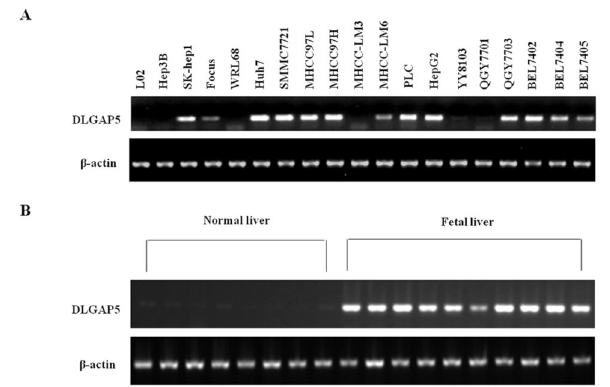
Figure 3. mRNA expression pattern of DLGAP5 in HCC cell lines, normal livers and fetal livers. (A and B) Results of the semi-quantitative RT-PCR analysis of DLGAP5 in 19 liver cancer cell lines (A) and in 8 normal liver tissues and 10 fetal liver tissues (B). β-Actin was used as an internal control. All PCR products were visualized by electrophoresis on 2% agarose gels.